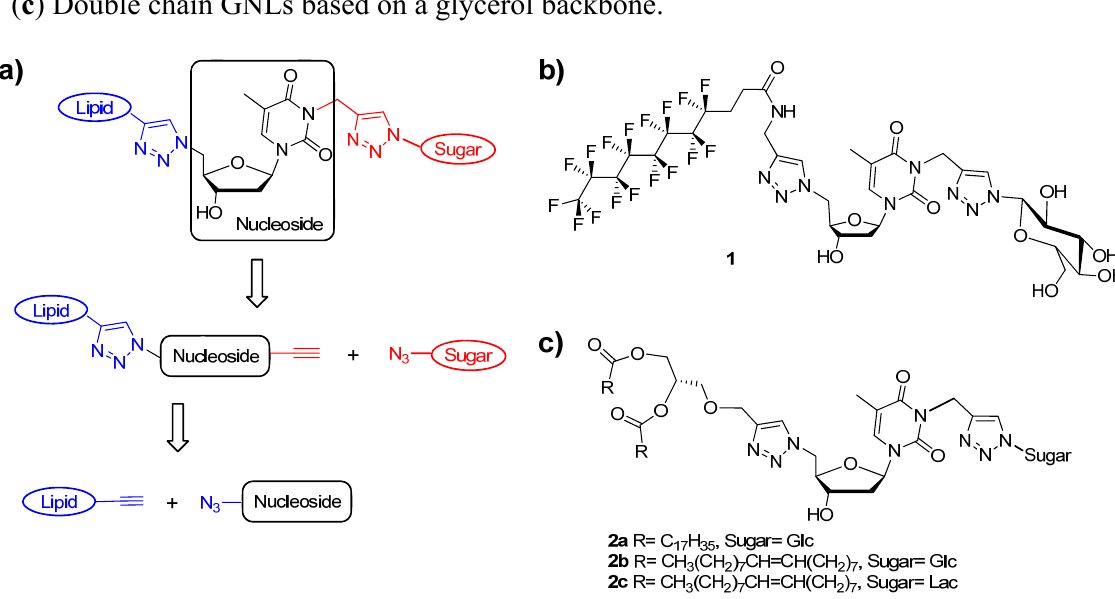
also designed by the acronym GNF (Glycosyl-nucleoside fluorinated amphiphile). ( c ) Double chain GNLs based on a glycerol